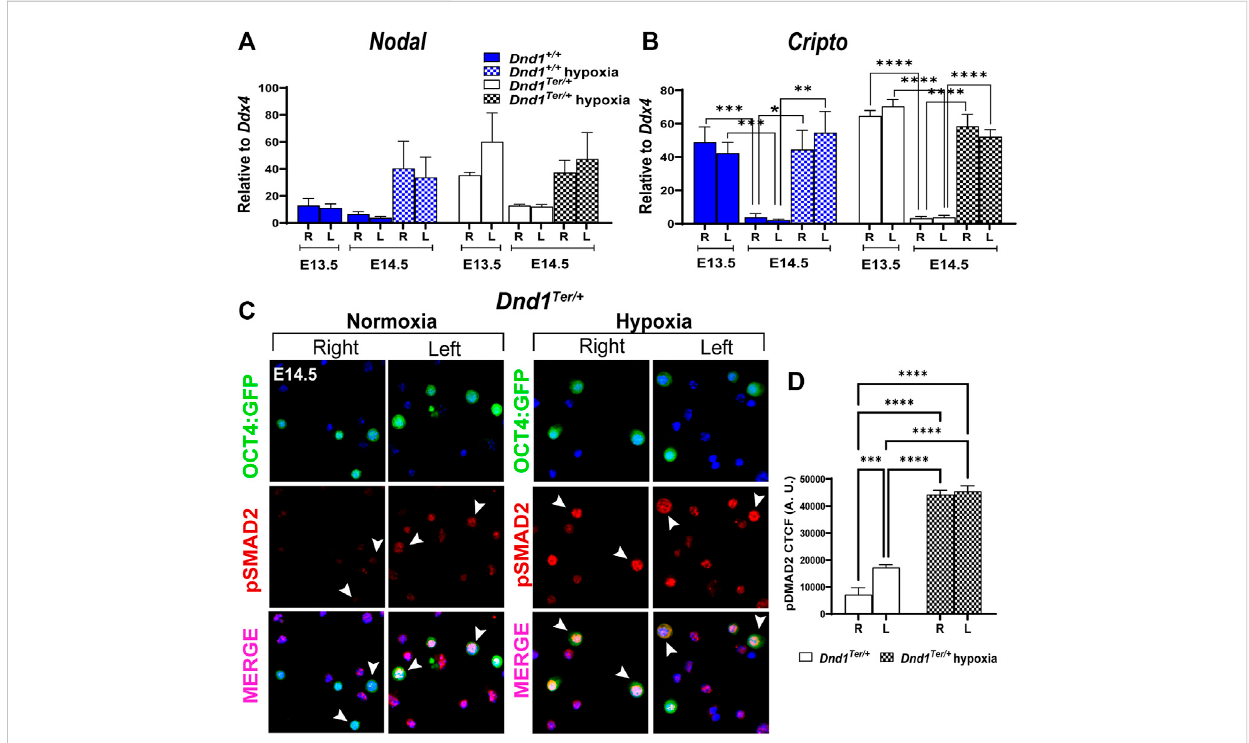
FIGURE 4 Hypoxia promotes the activation of the Nodal signal pathway. Pregnant females were exposed to hypoxia between E13.8 and E14.3. The hypoxic right (R) and left (L) gonads, together with normoxic controls, were dissected at E13.5 and E14.5. The OCT4:GFP(+) germ cells were sorted by FACS and totalRNAwasextractedtoperformqPCRevaluatingtheexpressionof (A) Nodal and (B) Cripto ( Dnd1 +/+ and Dnd1 Ter/+ atE13.5n=9; Dnd1 +/+ and Dnd1 Ter/+ at E14.5 normoxia n = 5; Dnd1 +/+ and Dnd1 Ter/+ at E14.5 hypoxia n = 8). Gene expression was normalized to Ddx4 . Statistical signi fi cance between groups of right and left gonads of different embryonic stage or oxygen levels were determined using one way ANOVA multicomparison test with Tukey ’ s correction. (C) Immunostaining of isolated germ cells (OCT4:GFP(+)). Germ cells isolated from the right and left gonads were attached to a slide (see methods) and stained using an antibody against phospho-SMAD2 (red). The nuclear staining was conducted using Hoechst 33,342 (blue). Arrowheads show double labeled OCT4:GFP+ and pSMAD2+ cells. Representative images of n = 3 experiments. (D) Corrected total cell fl uorescence (CTCF) of OCT4:GFP + cells positive for pSMAD2 is elevated in germ cells isolated from the left and right testis after embryonic exposure to